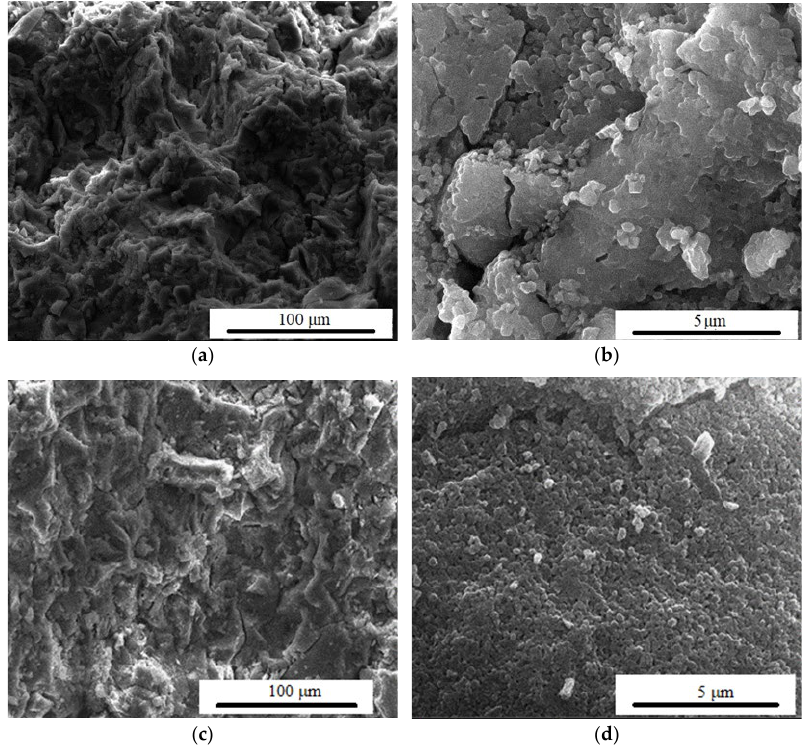
Figure 10. SEM images magnification ×1000 and ×20,000 of F1 ( a , b ) and F120s ( c , d ) samples, after 14 days in SBF (simulated body fluid).